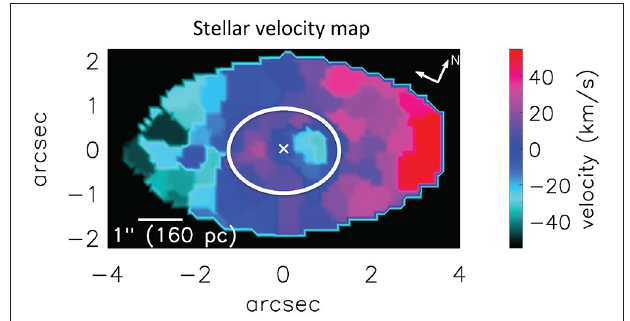
FIGURE 1 | Stellar velocity field for MCG–6-30-15. The region of the counter-rotating core is indicated by the white ellipse. The cross indicates the position of the AGN. Reproduced with permission from Raimundo et al. (2017).